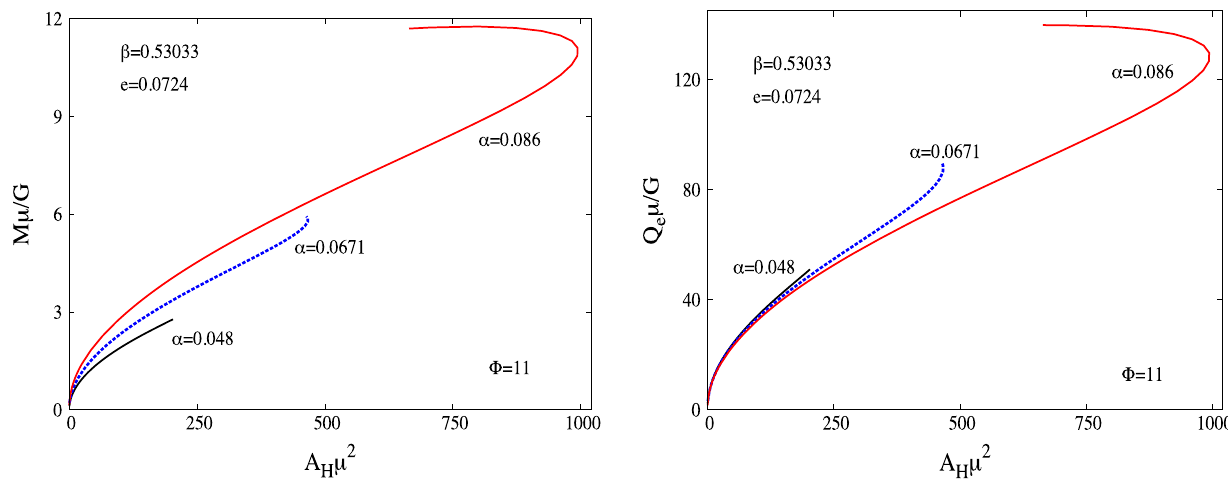
Fig. 3 ADM mass M (left panel) and electric charge Q e of the RN BHs with resonant scalar hair, for a fixed chemical potential (cid:17) and several values of the coupling constant α , v s . the horizon area A H